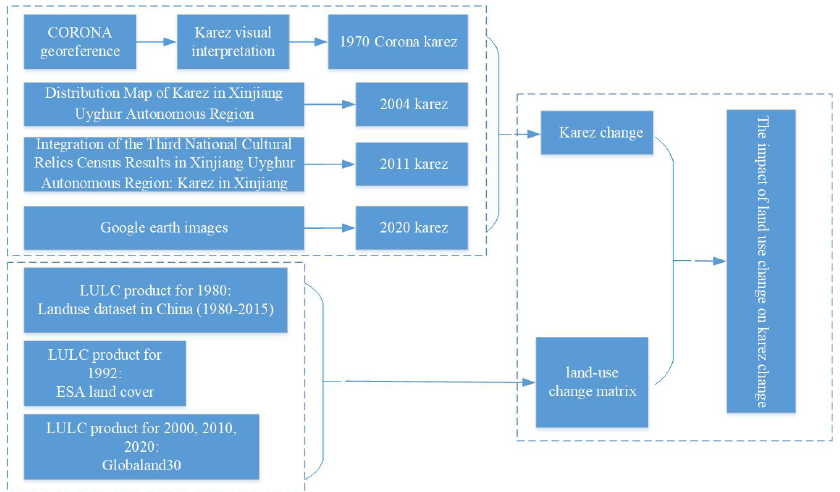
Figure 5. The overall technical roadmap for the analysis of the impact of land use/land cover change on karez in the Turpan